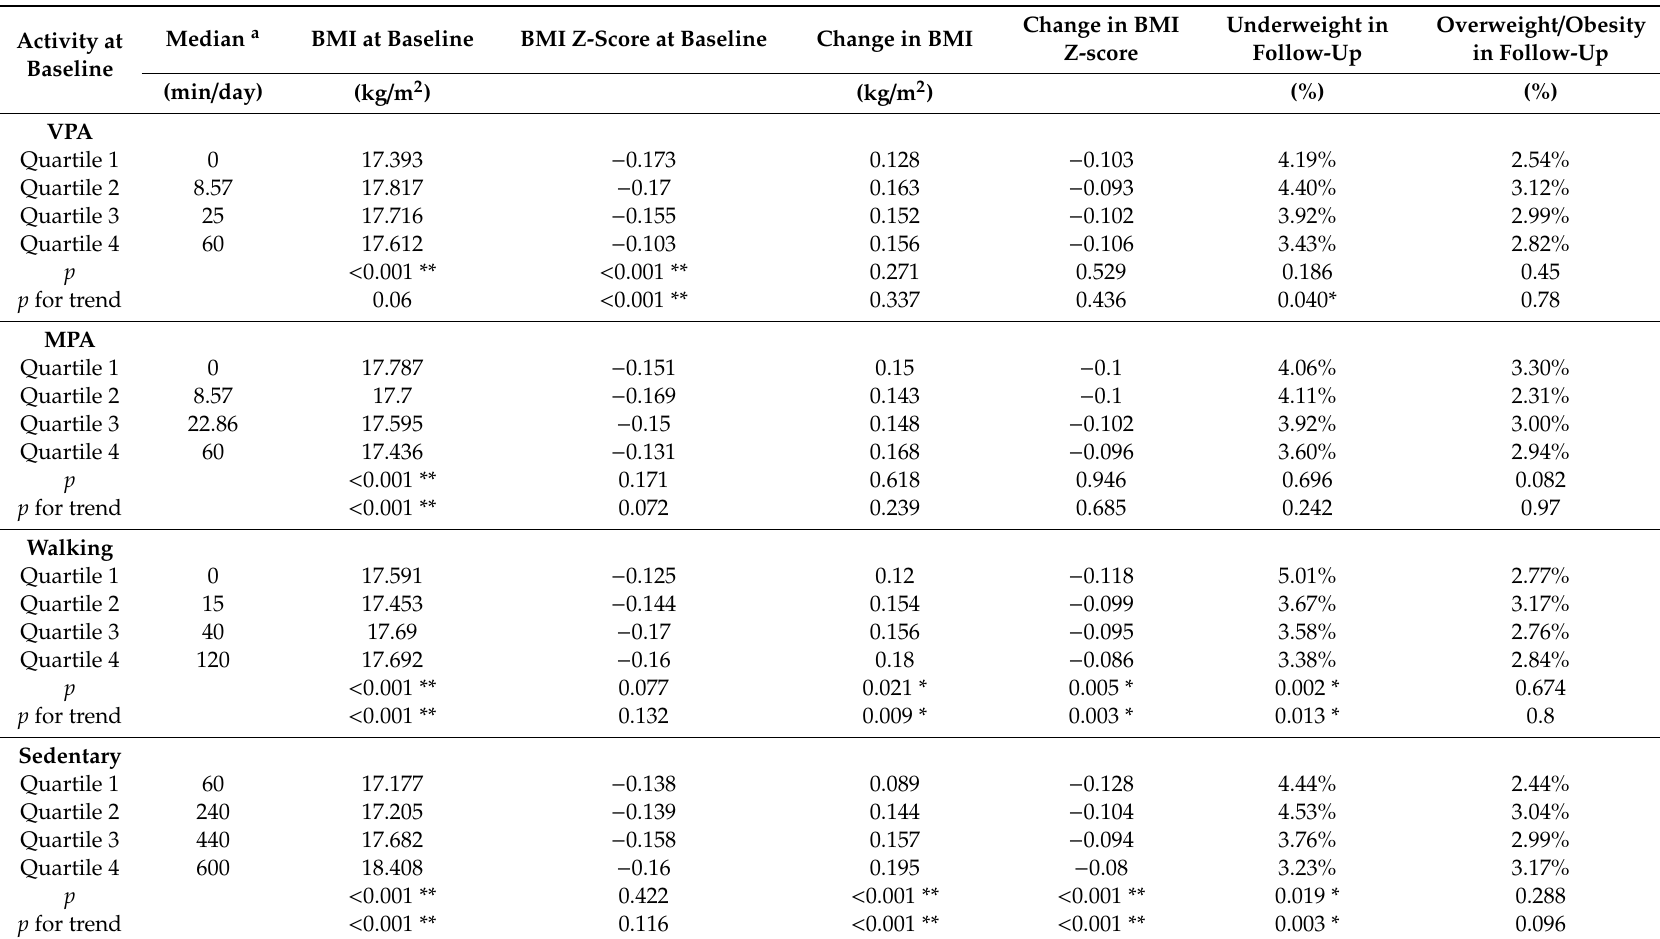
Table 3. Distribution of changes in BMI, BMI z-score and weight status according to quartiles of di ff erent intensity